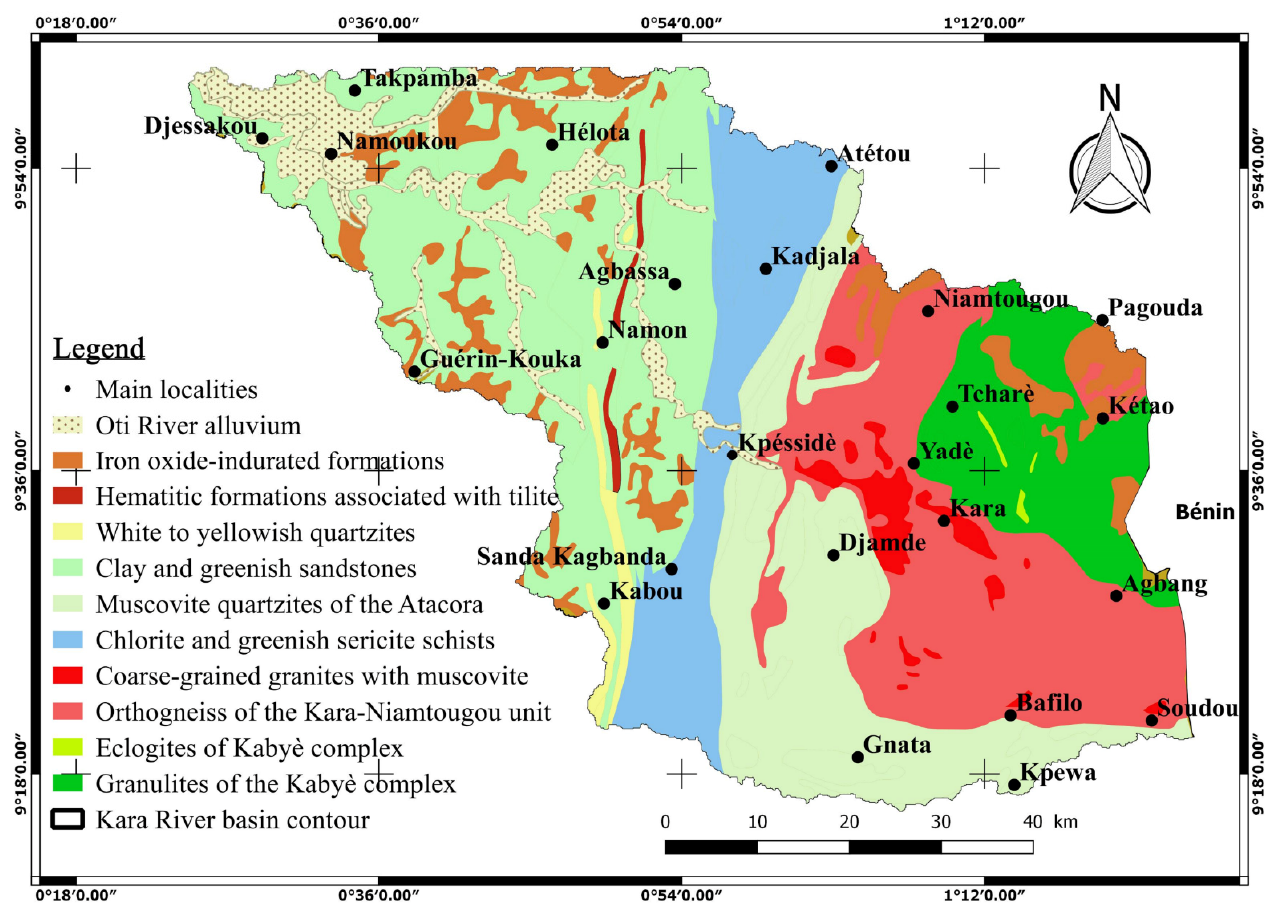
Figure 3. Simplified geological map of the Kara River watershed (modified after General Directorate of Mines and Geology, 1986).